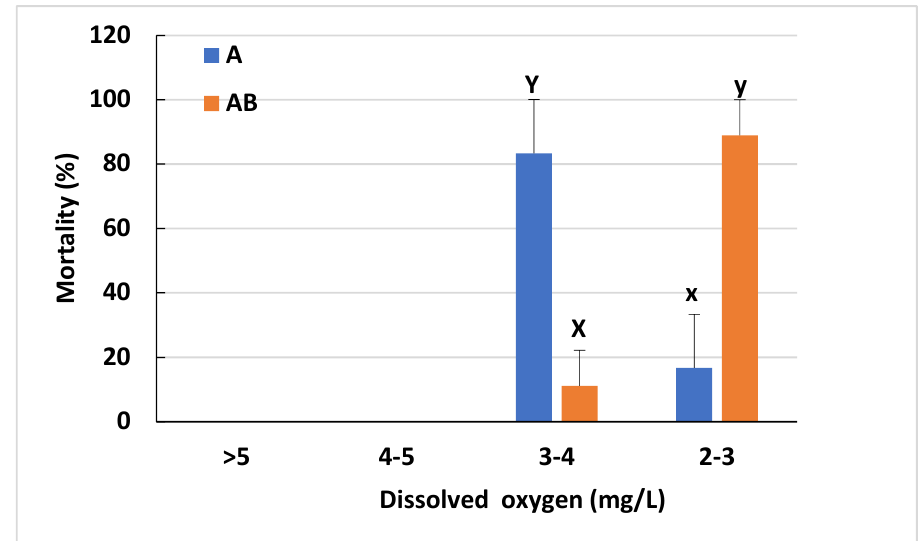
Figure 4. Mortality of sturgeon challenged by acute hypoxia after 6-week feeding (Trial III). Data were presented by means of mortality based on survival fish from three replications. Different letters indicated the significant difference between the two dietary treatments, with X and Y comparing the mortality that occurred at 3 – 4 mg/L dissolved oxygen: x and y comparing the mortality at 2 – 3 dissolved oxygen. A: sturgeon fed Artemia for 4 weeks before weaning to a commercial diet. AB: sturgeon co-fed Artemia and the commercial diet for 4 weeks before weaning to a commercial diet.